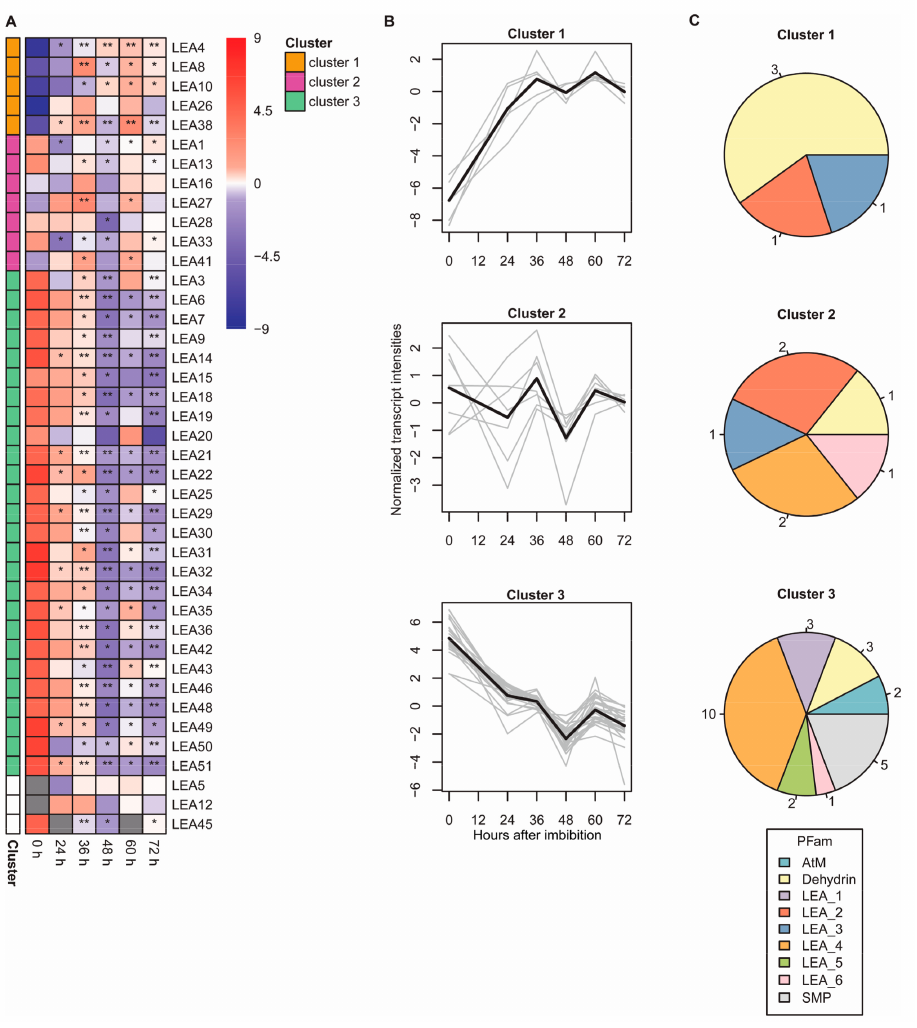
Figure 7. Transcript levels of genes encoding LEA proteins in dry seeds (DS), germinating seeds and seedlings after imbibition. ( A ) LEA transcripts at different time points after imbibition. The color gradient represents means of DW-normalized absolute transcript copy number in log 2 with median normalization ( n = 3). Gray boxes represent missing values at the indicated time point. Level of significance comparing LEA transcript abundance in germinating seeds and seedlings to DS (unpaired two-sided t -test) are indicated by asterisks (* p < 0.05; ** p < 0.01; *** p < 0.001). LEA transcripts are listed according to their LEA ID and corresponding clusters as determined by k-means clustering. Each cluster is represented by a unique color. LEA transcripts excluded from k-means clustering are depicted in white. ( B ) Patterns of LEA transcript abundance as determined by k-means clustering. Gray lines represent individual transcripts while black lines show the mean of each cluster. ( C ) Distribution of Pfam of LEA transcripts in each cluster. Each Pfam is represented by a unique color. Numbers in pie charts represent the numbers of Pfam